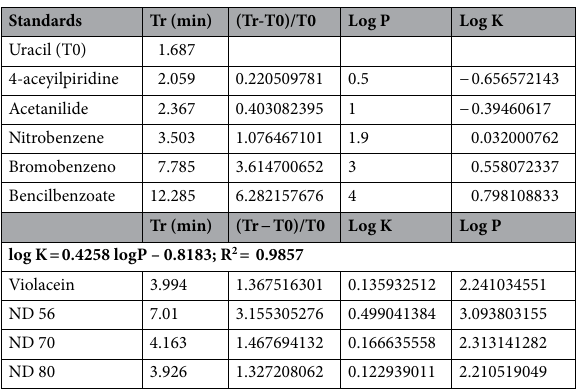
Table 2. Determination of log P for violacein. Uracil, 4-acetylpyridine, acetanilide, nitrobenzene, bromobenzene and benzyl benzoate, used as standards, were loaded in a C18 reverse phase Eclipse Plus column (5 µm, 4.6 × 150 mm) with 30:70 water:methanol as mobile phase, run at 1 ml/min flow, and detected at 220 and 254 nm using a diode array detector. All experiments were done in triplicate and results